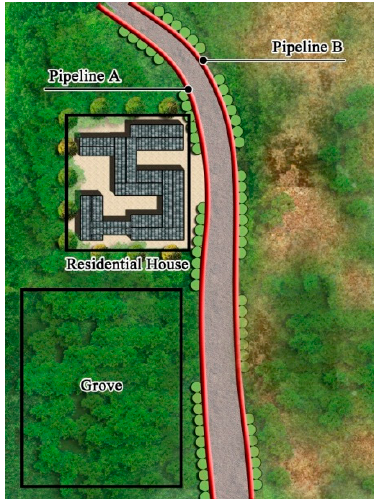
Figure 8. Trend map of the evaluated pipeline segment.